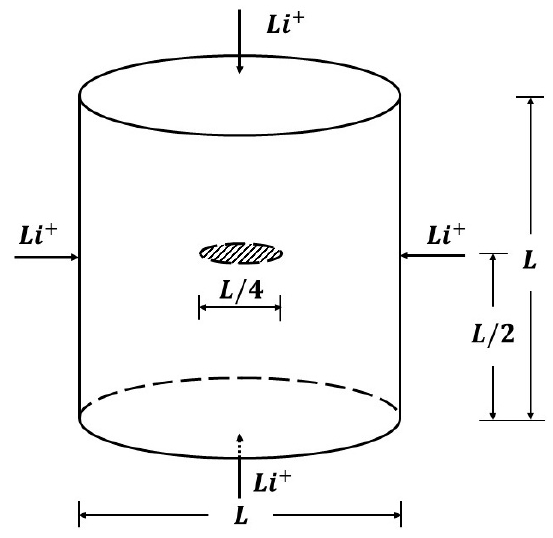
Figure 6. Cylindrical anode structure with a pre-existing horizontal crack.